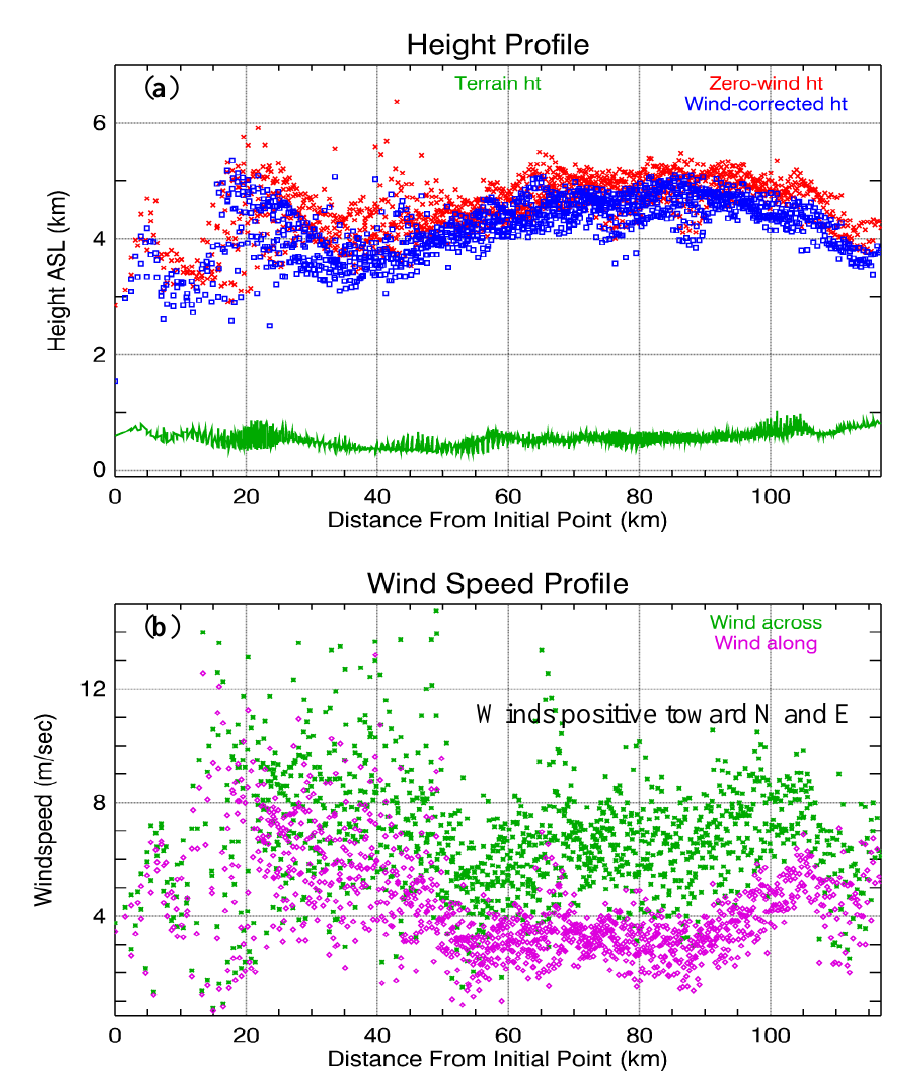
Figure 2. Data profiles produced automatically by MINX for the plume polygon digitized in Figure 1. Both profiles share a distance axis defined relative to the initial point digitized. ( a ) Height profiles: zero-wind heights in km are colored red, wind-corrected heights are blue and terrain heights are green. ( b ) Wind profiles: wind speeds in m·s −1 across track are colored light green and wind speeds along track are